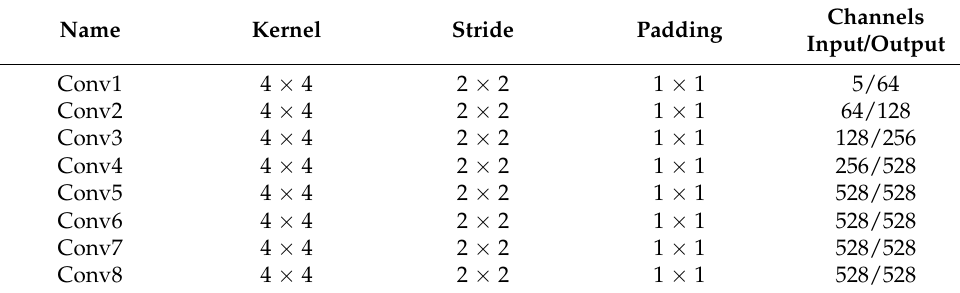
Table 3. Encoder part of generator used in UA-GAN (Stage 2).